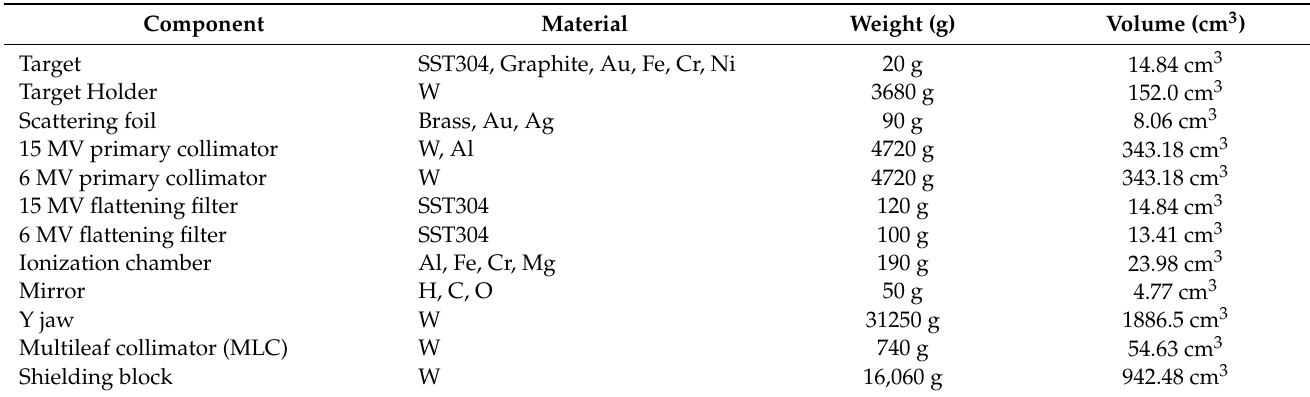
Table 2. Classification of the linac head components and characteristic.